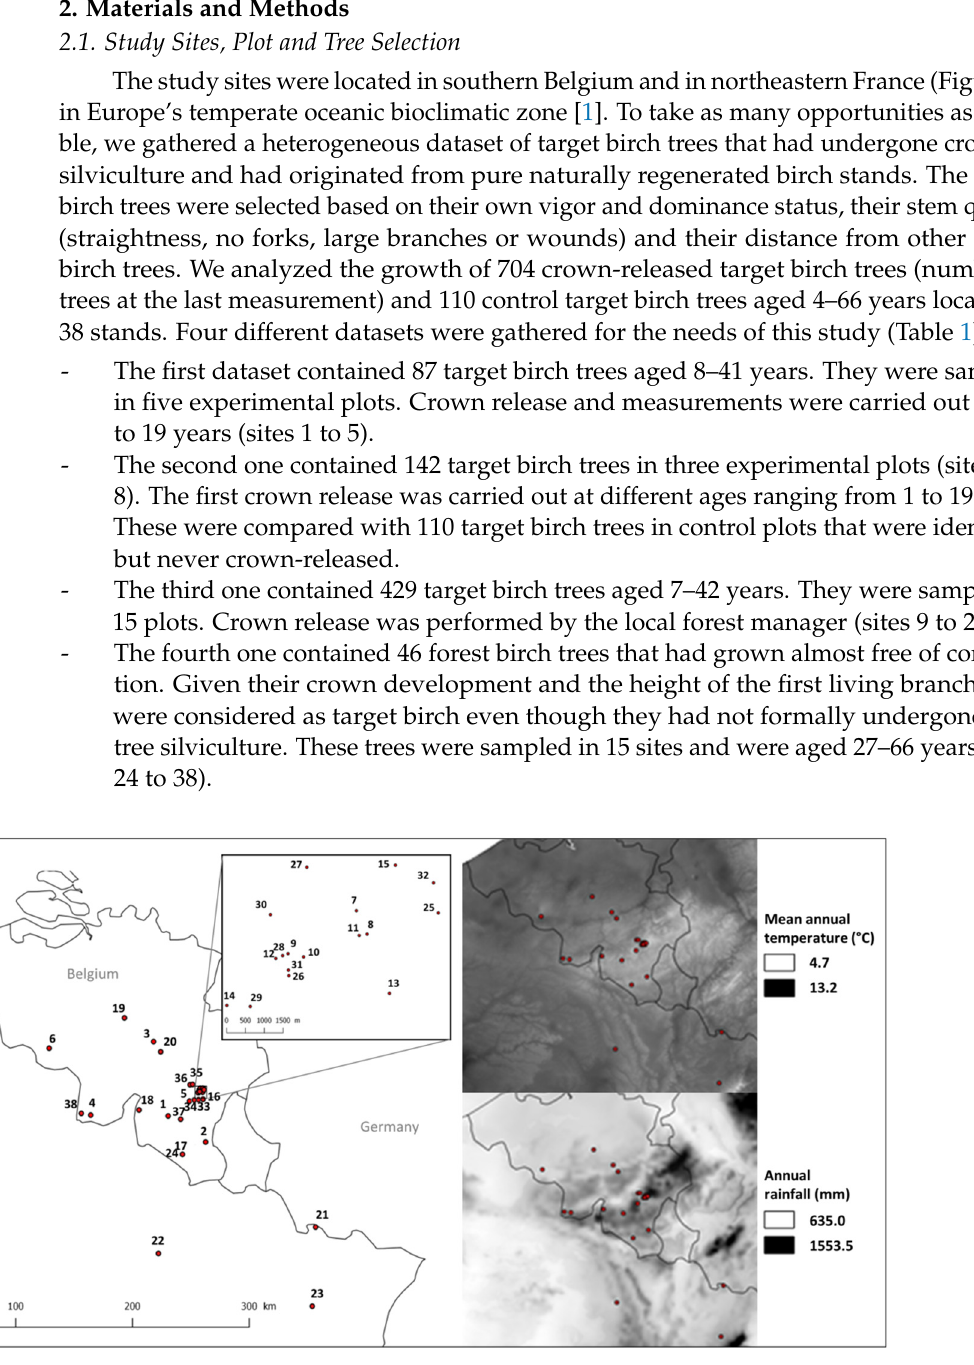
Figure 1. Site location and climatic gradient (mean annual temperature an annual rainfall) in the study area.